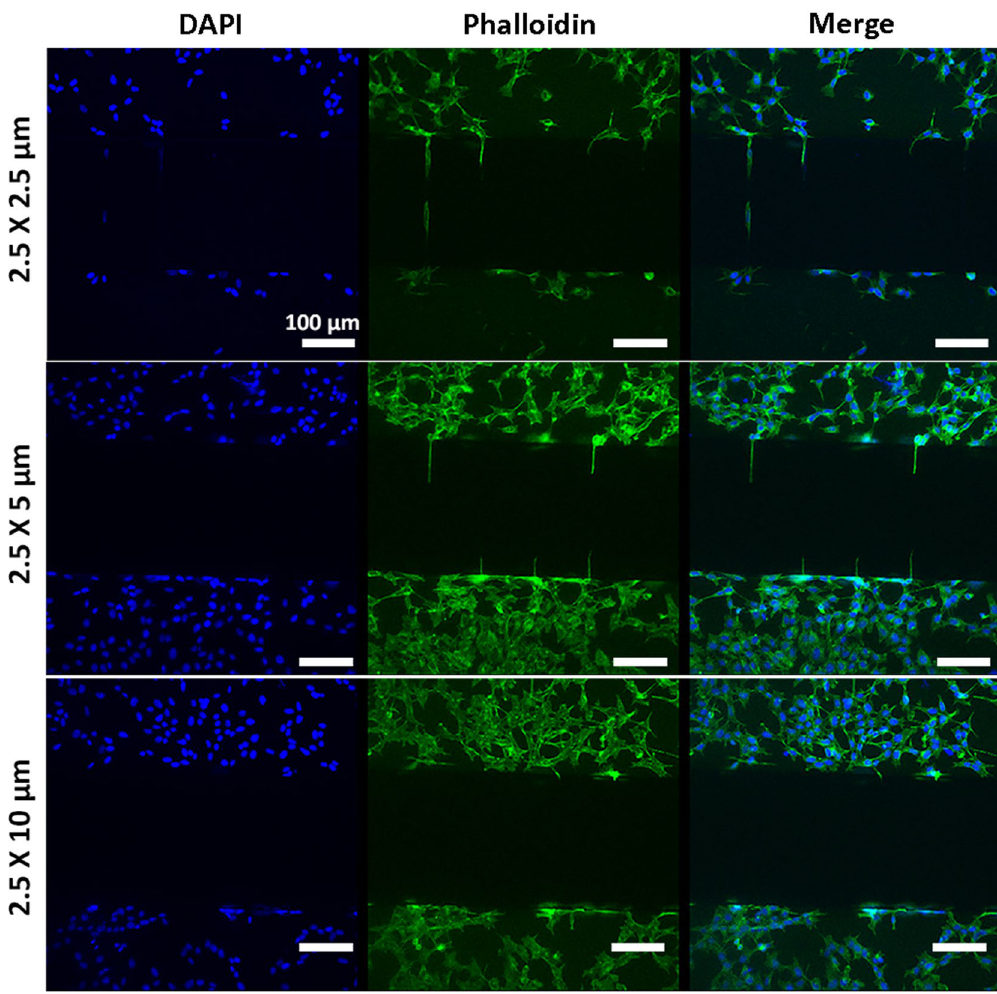
Figure 4. Fluorescent images of SH-SHY5Y cells cultured on devices having microchannels with different height × width section. DAPI and Phalloidin-FITC stained SH-SY5Y showed how only 2.5 × 5 µm geometry permitted neurite elongation, preventing soma migration. Scale bar: 100